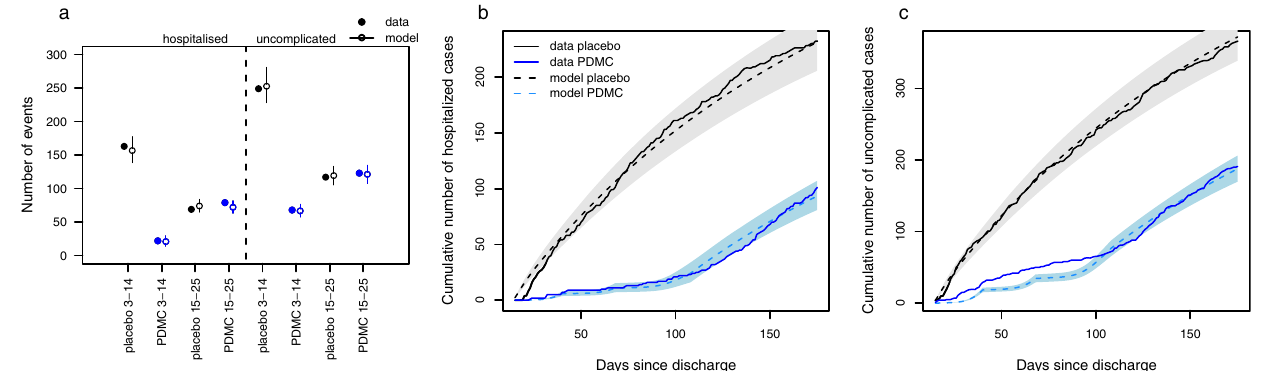
Fig. 1 | Model fi ts to trial data on number of malaria cases across all sites. a Hospitalised (left) and uncomplicated malaria (right) in weeks 3 – 14 and 15 – 25 post-dischargein PDMC (blue)and placebo (black)trialarms. 333 hospitalised and 557uncomplicatedmalariaepisodeswereexperiencedintotalamong524children inthePDMCgroupand525childrenintheplacebogroup.Modelpredictionsshow